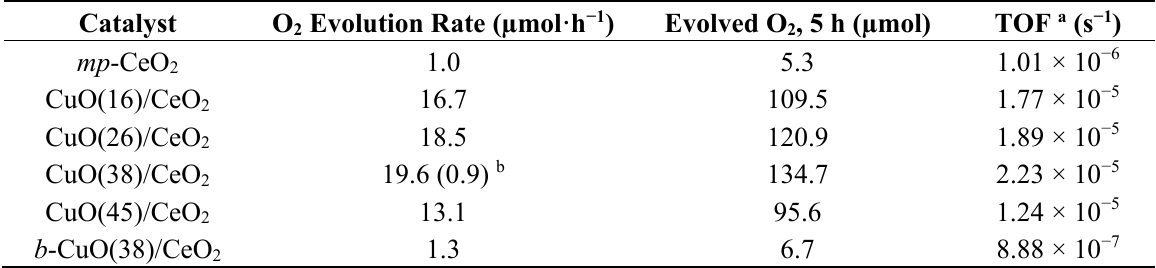
Figure 5. ( a ) Oxygen evolution curves and ( b ) time courses of photocatalytic O 2 evolution rates for mesoporous mp -CeO 2 and CuO/CeO 2 composite materials and bulk b -CuO(38)/CeO 2 solid. Table 2. Oxygen evolution reaction (OER) photocatalytic activity of the mesoporous mp -CeO 2 and CuO/CeO 2 materials and bulk b -CuO(38)/CeO 2 solid.